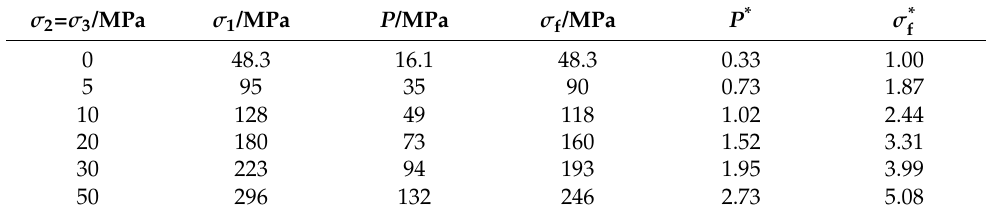
Table 1. Mechanical parameters under different confining